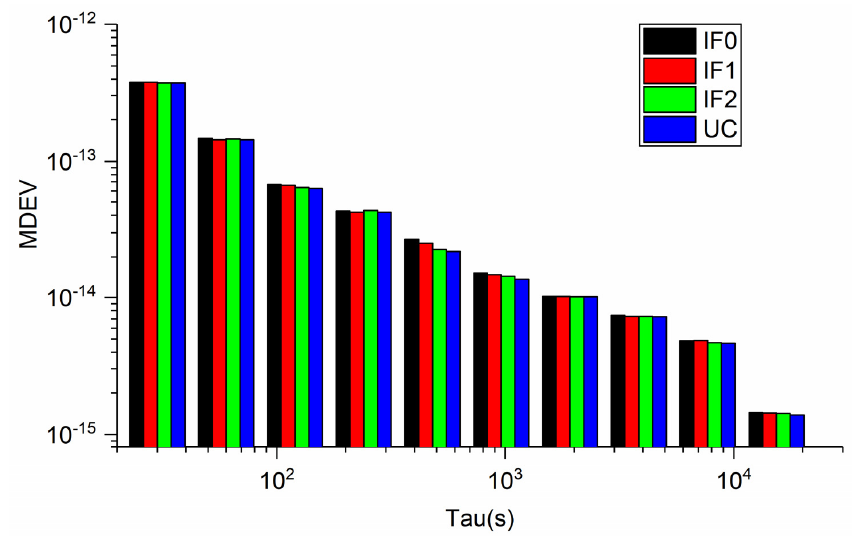
Figure 14. Comparison of MDEV between different Galileo PPP models for PTBB-PT11 on DOY 277,